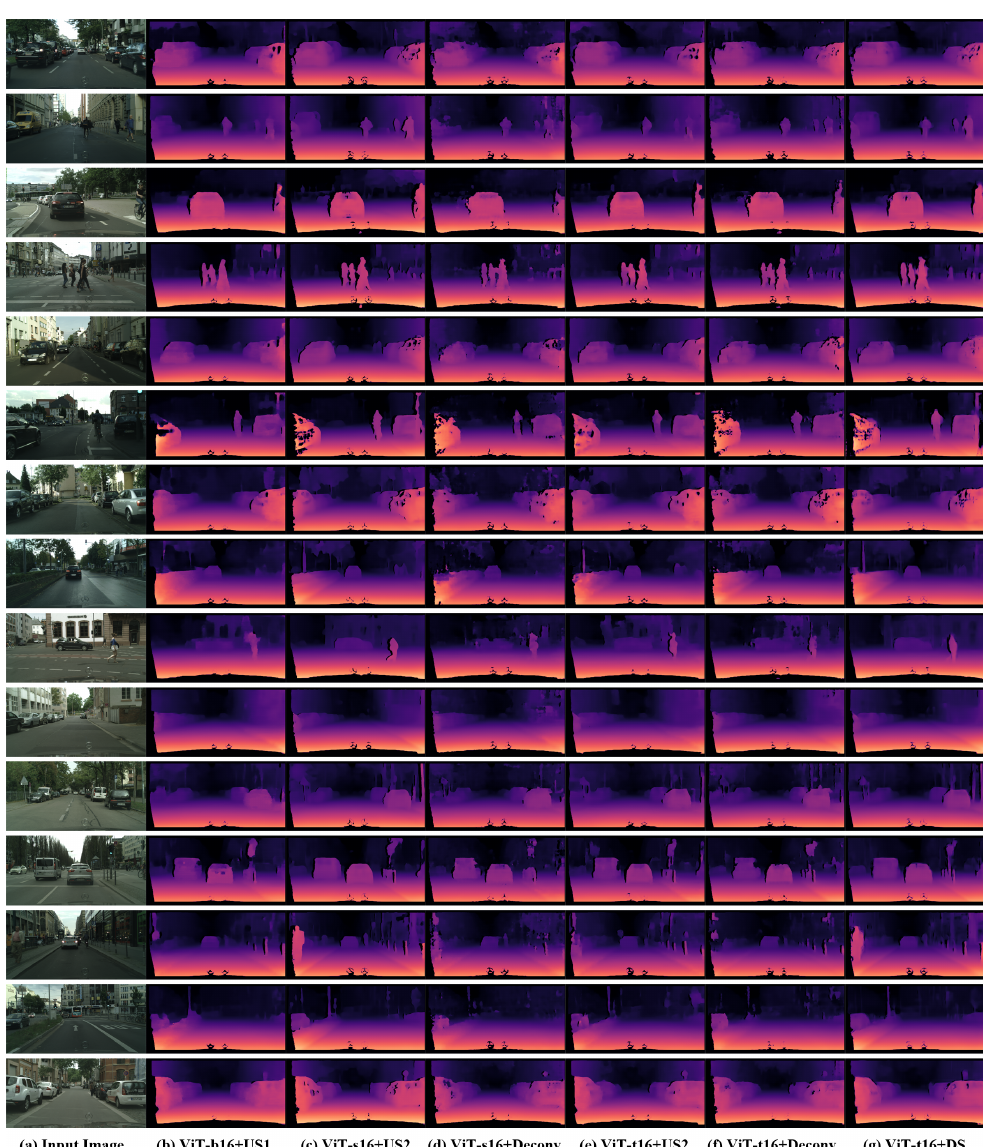
Figure A1. Sample results obtained from the proposed architectures on Cityscape validation-set: ( a ) the input image, ( b – g ) are the depth estimation results obtained from the architecture mentioned below the column, ( b ) ViT-b16 encoder and US1 decoder, ( c ) ViT-s16 encoder and US2 decoder, ( d ) ViT-s16 encoder and the Deconv decoder, ( e ) ViT-t16 encoder and US2 decoder, ( f ) ViT-t16 encoder and the Deconv decoder, and ( g ) ViT-t16 encoder and (depth-to-space) DS